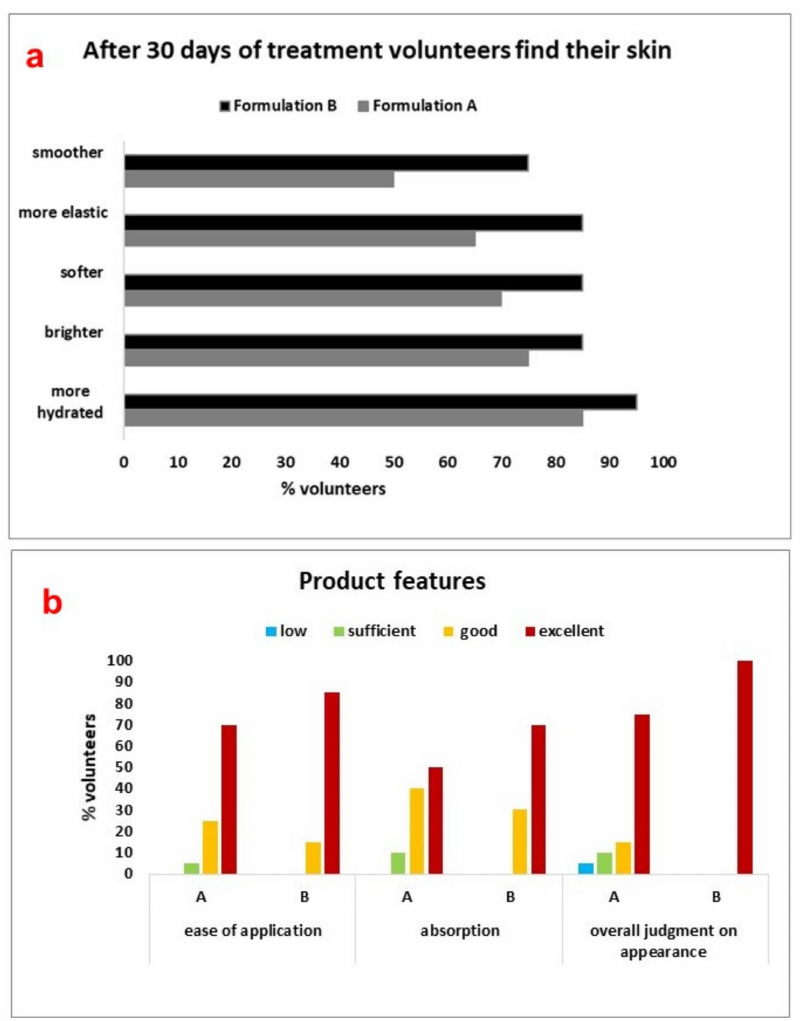
Figure 13. Results obtained from the sensory analysis performed by the volunteers through the self-assessment test, after the application of A and B. ( a ) shows the perception of the skin (elasticity, smoothness, brightness) after the application; ( b ) shows overall opinion (easy application, absorption, and appearance) of the volunteers on the two